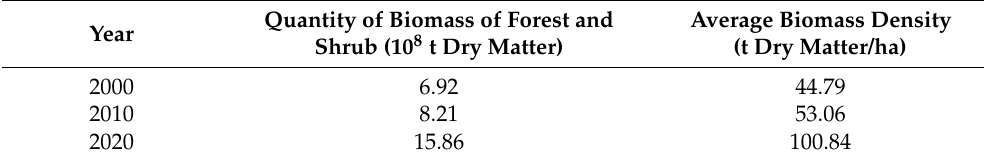
Table 3. Biomass and biomass density of forest and shrub.